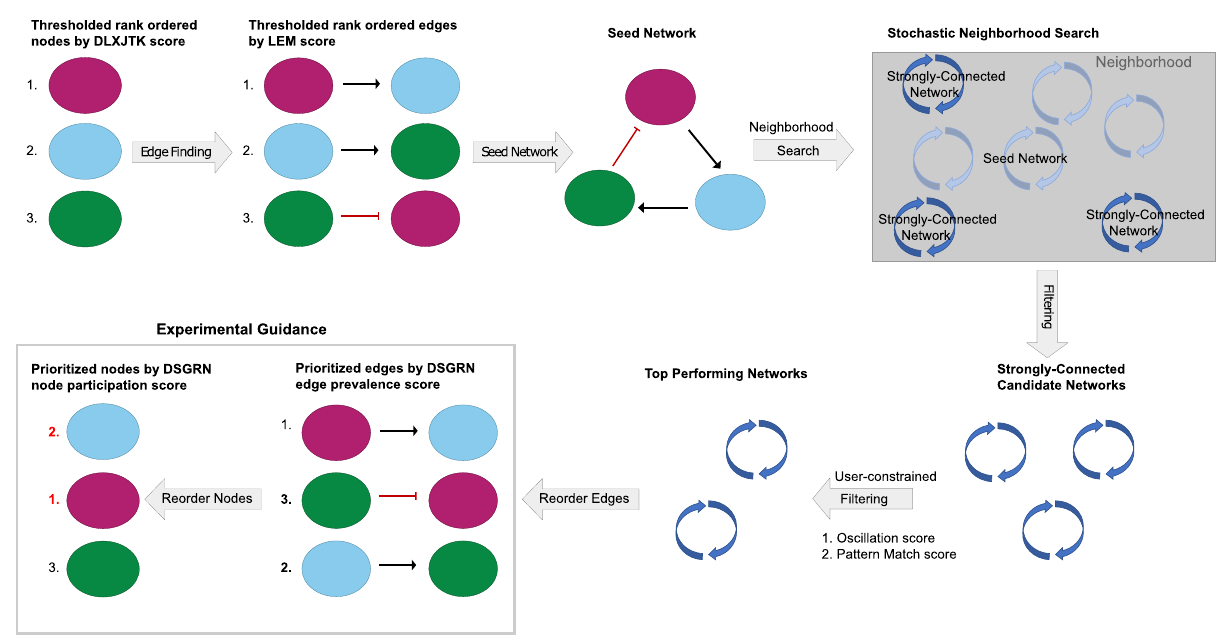
Fig 2. Schematic of the network finding step. From upper left in a horseshoe to lower left: The node finding step produces a thresholded list of nodes that are passed into edge finding. Edge finding ranks all possible edges between these top nodes and the very top ranked of these are used to create a seed network. The seed network is the initial condition for a neighborhood search in network space. In this neighborhood, a collection of strongly connected networks are sampled and scored according to user-specified choices of the oscillation and pattern match scores in Table 1. The participation and prevalence of nodes and edges in the top ranked networks globally matching the dynamics in the experimental data permit a reordering of nodes and edges that provides hypotheses for experimental guidance.